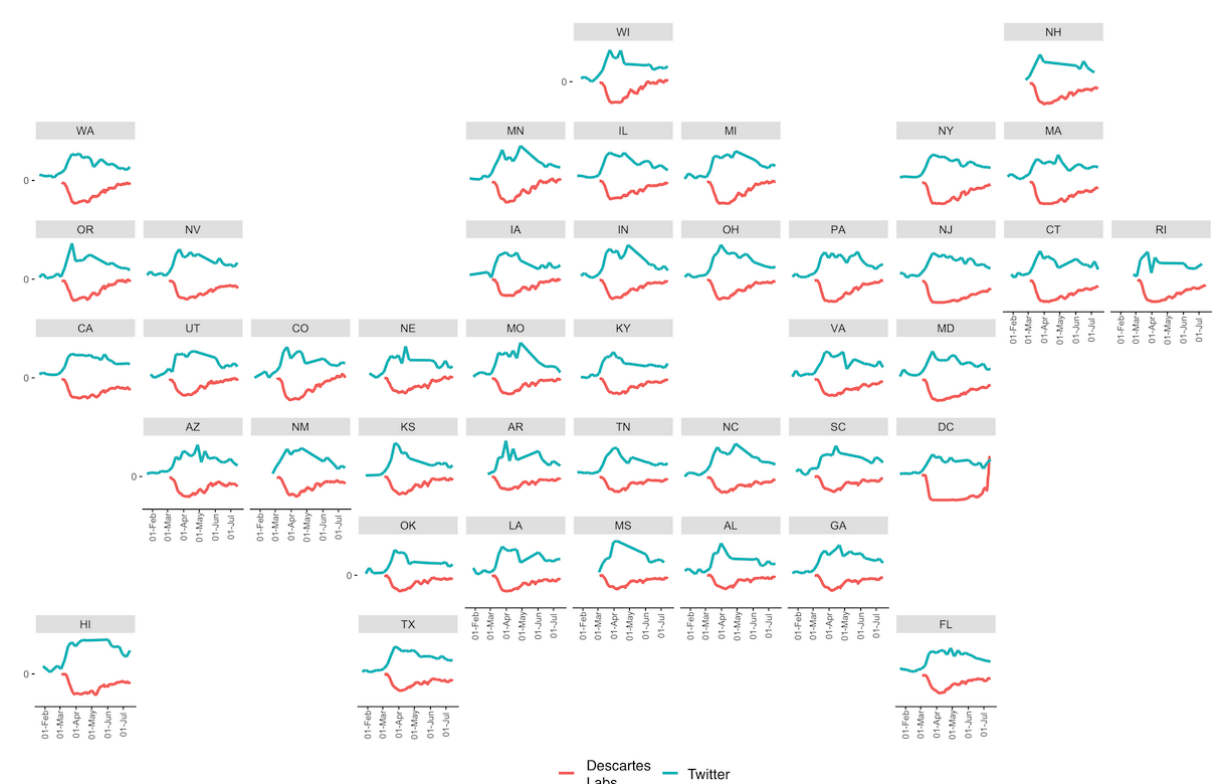
Figure 4. US state patterns in mobility compared to social distancing tweets from January to July 2020. Descartes Lab data showing a rolling 7-day average of percent change in mobility (divided by 5, to improve visualization) is plotted alongside the proportion of social distancing tweets per week. Both temporal and regional patterns are clear. Further, as the proportion of social distancing tweets increased, mobility measured by Descartes Labs decreased. States without sufficient Twitter data were removed from the grid. 2-letter abbreviations are used for each